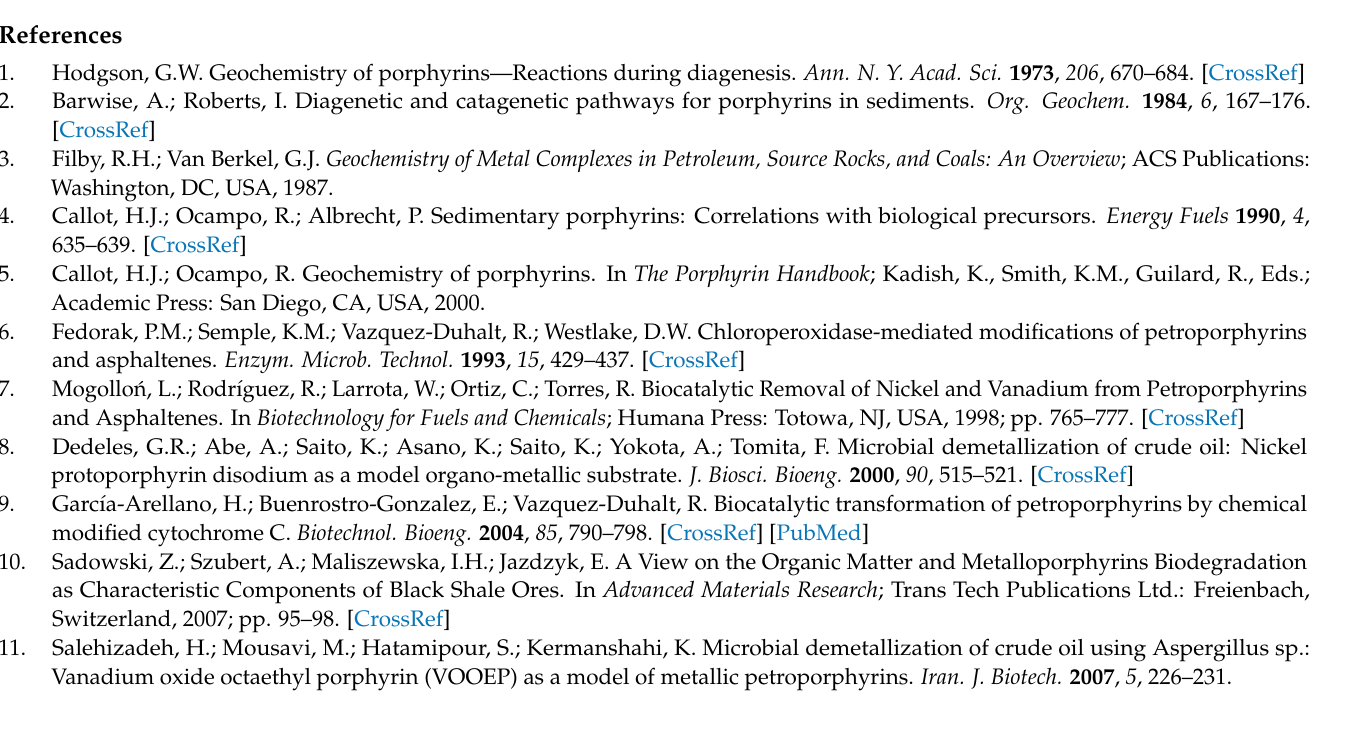
SIM chromatogram of CoPPIX is presented in Figure S1 (Supplementary information A), Figure S27. Accumulation of CoPPIX by LM27 strain: percentage content of cobalt in supernatant and cells of CoPPIX-BC after 10, 20, and 30 days of cultivation, Figure S28. Detection of heme in the sediments of CoPPIX-BC and CoPPIX-SC—HPLC-PAD chromatograms at 400 nm. HPLC-PAD chromatogram of heme is presented in Figure S13A (Supplementary information A), Figure S29. High-performance liquid 3D chromatograms of organic extracts of sediments obtained using HPLC-PAD, Figure S30. High-performance liquid 3D chromatograms of organic extracts of supernatants obtained using HPLC-PAD, Figure S31. UV–Vis spectra of organic extracts of sediments obtained using HPLC-PAD, Figure S32. Detection of heme (carbon, nitrogen, and iron) in CoPPIX-BC and CoPPIX-SC—GC-AED chromatograms. AED chromatogram of heme is presented in Figure S5 (Supplementary informa- tion A), Table S1. Concentrations of CoPPIX in BISR and SR based on GC-MS analyses of m / z 621, Table S2. Concentrations of CoPPIX in SR-BC and SR-SC based on GC-MS analyses of m / z 621, Table S3. Concentrations of CoPPIX in CoPPIX-BC and CoPPIX-SC based on GC-MS analyses of m / z 621, Table S4. Numbers of sequences of enzymes involved in heme biosynthesis and uptake and cobalt insertion/disconnection detected in the metaproteome (BISR) and proteomes (SR-BC, CoPPIX-BC); EC—enzyme catalogue, Table S5. Numbers of hemoprotein sequences detected in the metaproteome (BISR) and proteomes (SR-BC,